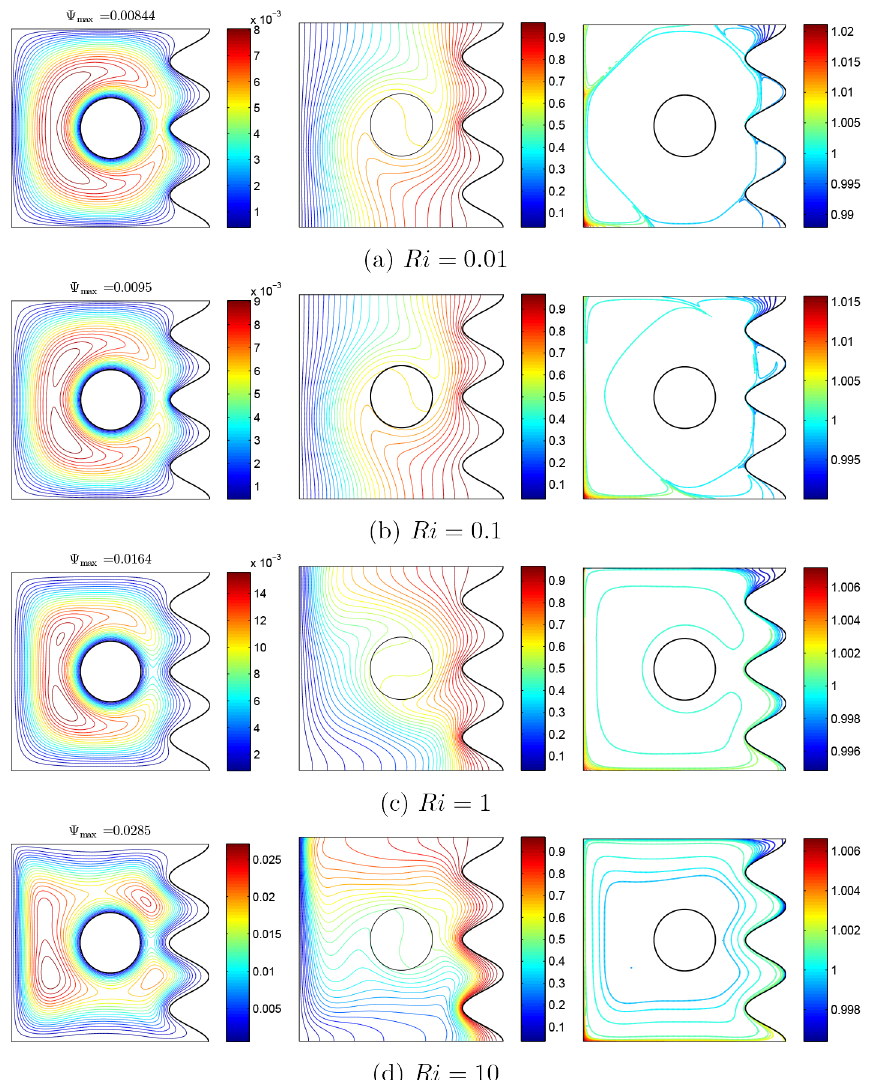
Figure 7. Variations of the ( left ) streamlines, ( middle ) isotherms, and ( right ) nanoparticle distribution evolution by Richardson number ( Ri ) for Case 2 ( − Ω ), φ = 0.02, N = 3, and R = 0.15.